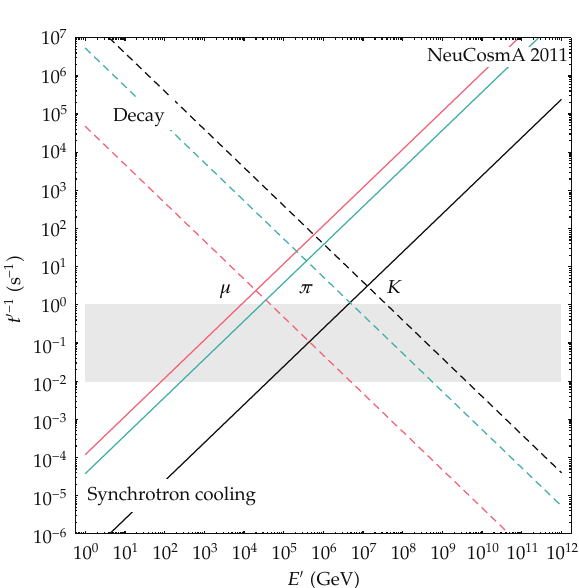
Figure 3: Synchrotron cooling and decay rates for pions, muons, and kaons as a function of energy for a magnetic field of B (cid:3) (cid:9) 300kG. The gray-shaded region shows the estimated range for the escape (cid:3) or adiabatic cooling (cid:4) rate for GRBs for a variability timescale ranging from 0.01s to 1s, figure taken from (cid:5) 30 (cid:6)